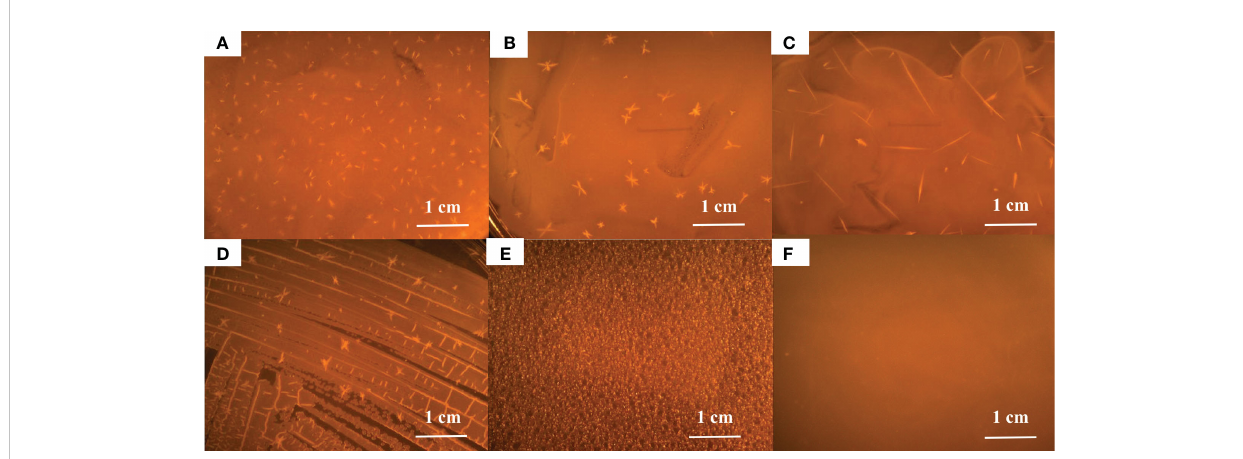
FIGURE 1 Mineral crystals induced by Alteromonas on TSA+2.5% sea salt. (A) , A. alteriprofundi HHU 13199 T ; (B) , A. alterisediminis N102 T ; (C) , A. chungwhensis KCTC 12239 T ; (D) , A. iocasae MCCC 1K03884 T ; (E) , A. lutimaris KCTC 23464 T ; (F) ,